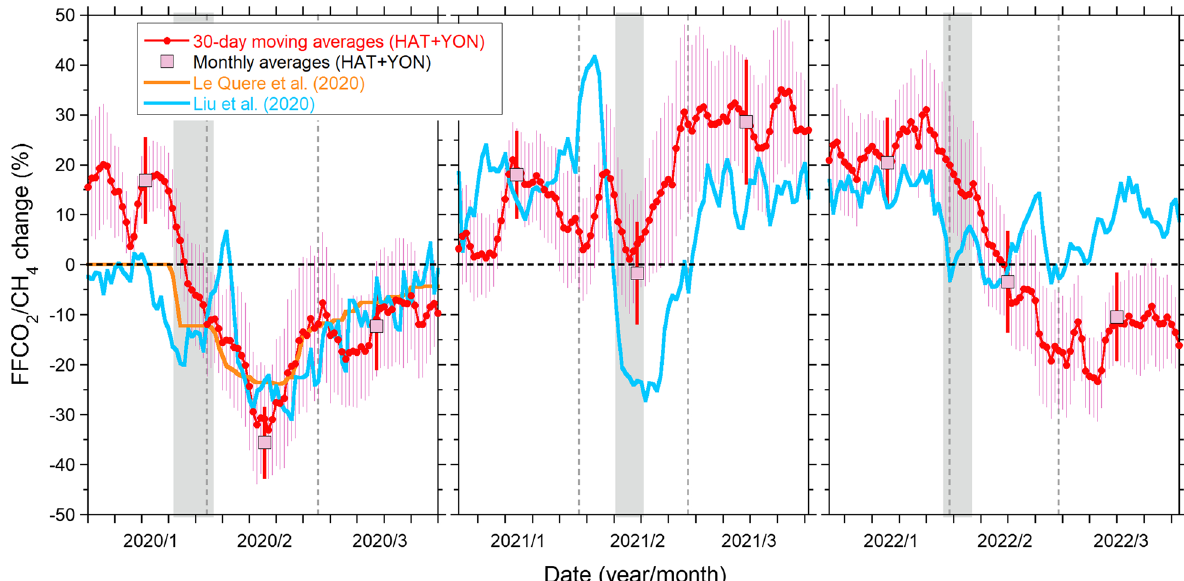
Fig. 7 Estimated FCO 2 /CH 4 emission change in China based on the ΔCO 2 /ΔCH 4 ratios observed at HAT and YON. The estimated results for 3 months (January, February, and March) in 2020, 2021, and 2022 are depicted in the left, middle, and right panels, respectively. The red circles with red lines and pink squares represent the estimates based on the 30-day moving averages and monthly averages, respectively, of the observed ΔCO 2 /ΔCH 4 ratios. The vertical bars represent the uncertainties. For comparison, the temporal changes in FFCO 2 emissions from China based on the bottom-up estimates of Le Quéré et al. (2020) (orange line) and Liu et al. (2020) (light blue line) are also shown. The gray-shaded areas correspond to the Chinese New Year